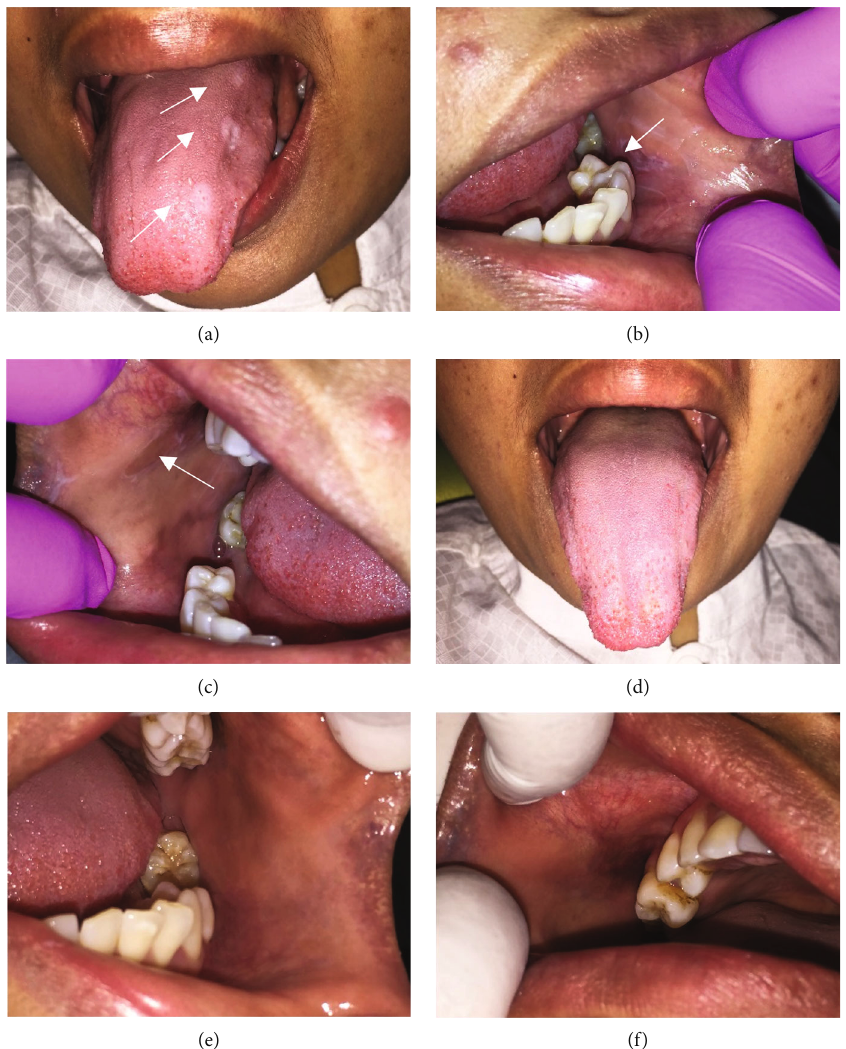
Figure 4: The clinical features of OLP in a 32-year-old woman; (a) multiple white plaques on the dorsum of the tongue; (b) and (c) erosive lesions surrounded by Wickham striae on the right and left buccal mucosa; (e) – (g) oral lesion was completely healed after three months of